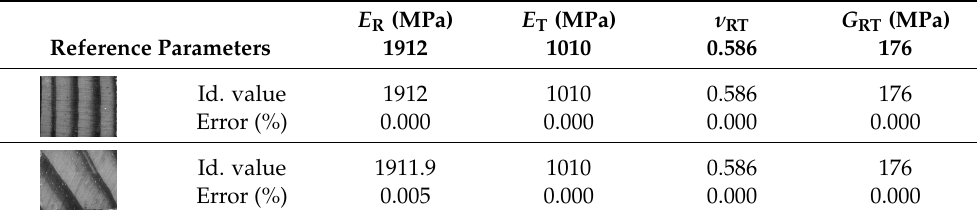
Table 5. Identification results for an on-axis specimen and an off-axis specimen, using a DIC-levelled FEA reference with reference parameters [2,55].